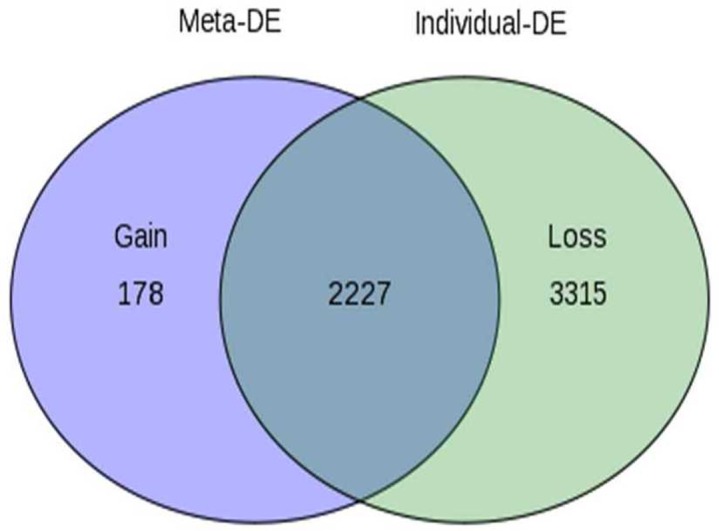
Graphical representation of the number of DEG from the meta-analysis.